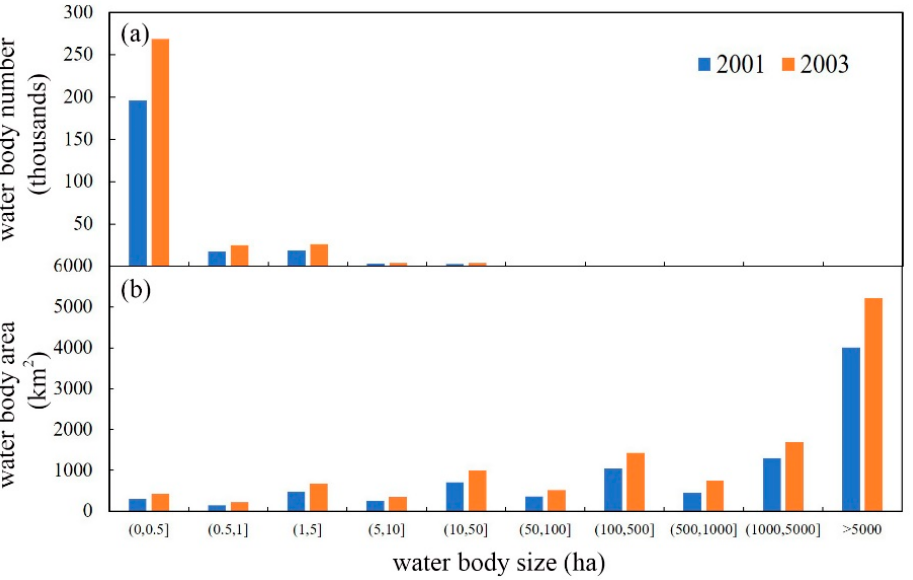
Figure 10. The distribution and area distribution based on the water body range in 2001 and 2003: ( a ) The water body number distribution; ( b ) the water body size distribution.